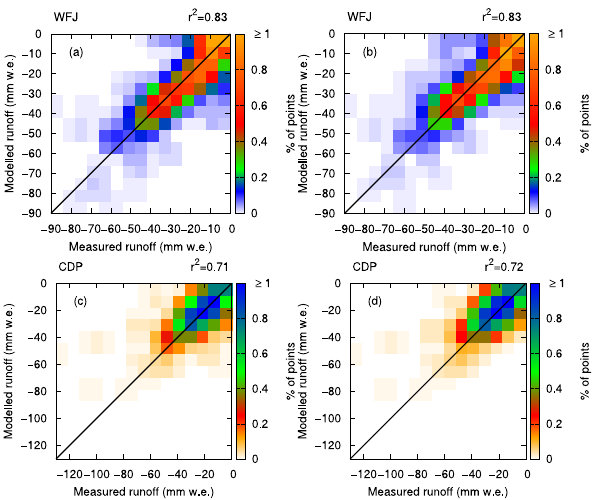
Fig. 8. Density scatter plots for modelled versus measured snow- pack runoff (mm) for the 1h time scale for the bucket scheme (a, c) and RE (Yamaguchi) model (b, d) for both WFJ (a, b) and CDP (c, d) . In colour are shown the percentages in the specific region, cut off at 1%. Data is divided in 15 × 15 bins. For an improved dis- tinction between WFJ and CDP results, the colour scale for CDP is